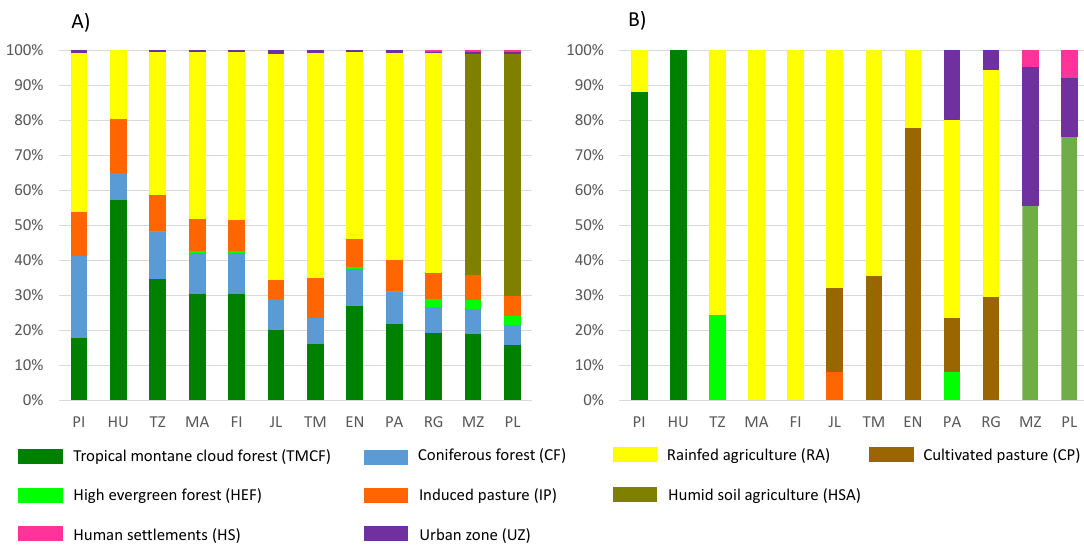
Figure 5. Percentage of land use in each study site. ( A ) Percentage of land use for watershed upstream from each study site. ( B ) Percentage of land use for the upstream 500 m × 2 km buffer zone.